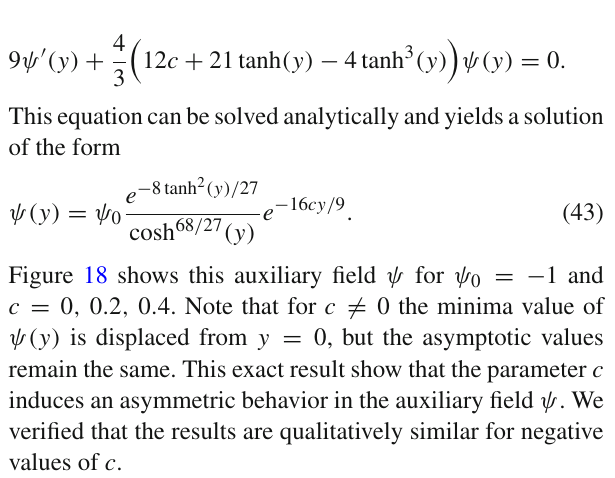
Fig. 19 Plot of ϕ( y ) for ψ 0 = 1 and ϕ 0 = 1 . 45, with c = 0 (thick solid line), c = 1 (thin solid line), and c = 0 . 4 (dashed line)